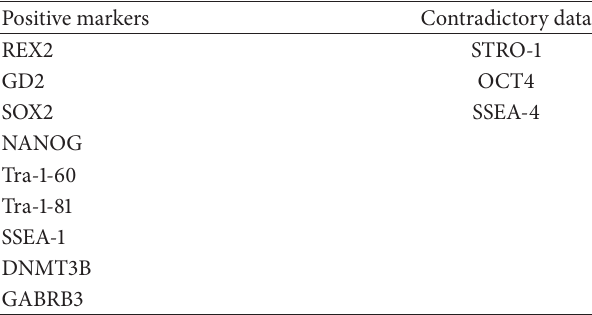
Table 2: The expression of pluripotency markers on UC-MSCs (according to [2,